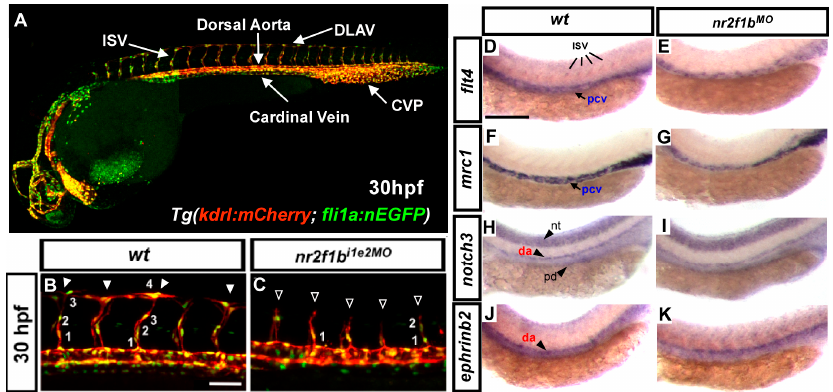
Figure 2. Study the function of genes in vascular development. ( A ) Confocal image of transgenic fish Tg(kdrl:mCherry; fli1a:nEGFP) where mCherry expression is in the endothelial cells and GFP expression is in the nucleus at 30 hpf. The image shows clear vessel structures of the dorsal aorta (da), cardinal vein (pcv), ISV, DLAV and CVP. ( B , C ) Knockdown of nr2f1b in transgenic fish results in vascular